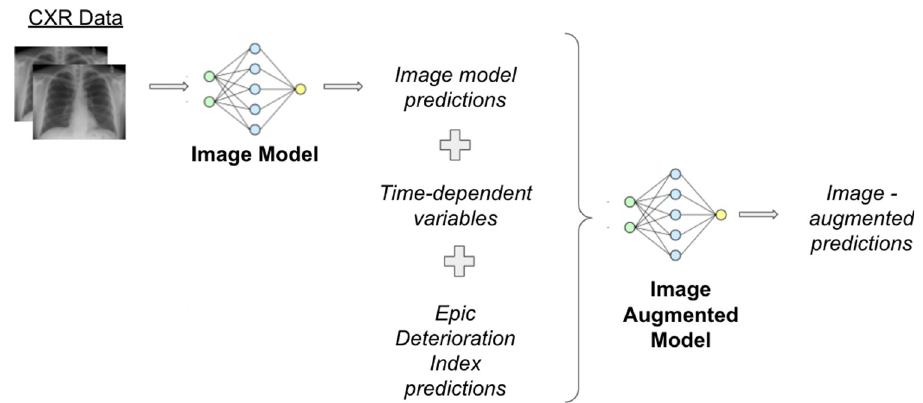
Fig 1. Image-augmented deterioration model. The image-augmented deterioration index combines outputs from an image model, an EHR deterioration index, and two time dependent variables encoding the time since the chest x-ray was performed and the time since the patient was admitted. Both the EHR deterioration index and image model can be varied. We provide additional details of chest x-ray preprocessing in the S1 Fig.